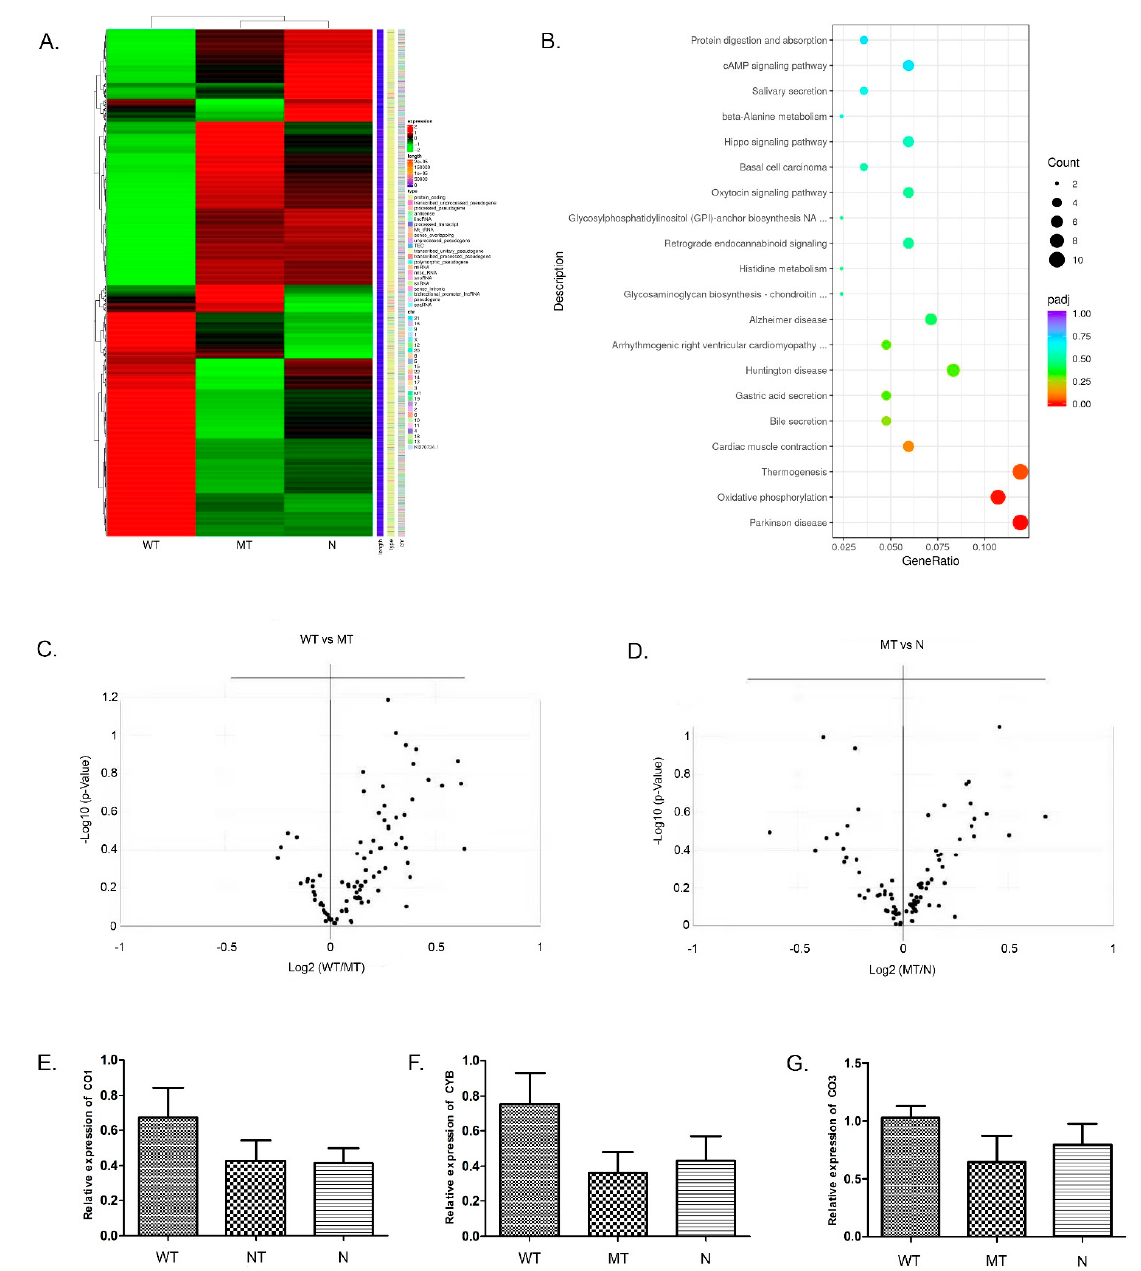
Figure 3 . Gene expression profile of 293T cells with a de novo mutation (c.352C>T). ( A ) Heatmap of RNA-seq. A differential gene set of 2181 genes was obtained when the differential genes of all comparison groups were combined. The results of RNA-seq showed that the expression pattern in HEK293T cells transfected with the mutant was similar to that in the normal controls but significantly differed from that in the wild-type transfected cells. ( B ) KEGG pathway analysis of the up-regulated genes. The size and color of the circles correlate with the number of DEGs and the -log10 ( p -value), annotated in the specific KEGG pathway, respectively. ( C , D ) PCR-array analysis for the genes related to the oxidative phosphorylation complex. The results indicated that most of the genes were up- regulated in the WT group. In contrast, gene expression patterns were very similar between the MT and N groups. The differentially expressed genes were normally distributed. ( E – G ) Verification of differentially expressed genes. The expression levels of some genes encoded by mitochondrial DNA, such as COX1, COX3, and CYB in the WT group, were higher than that in the MT and N groups, while the expression levels between the MT group and N group did not differ